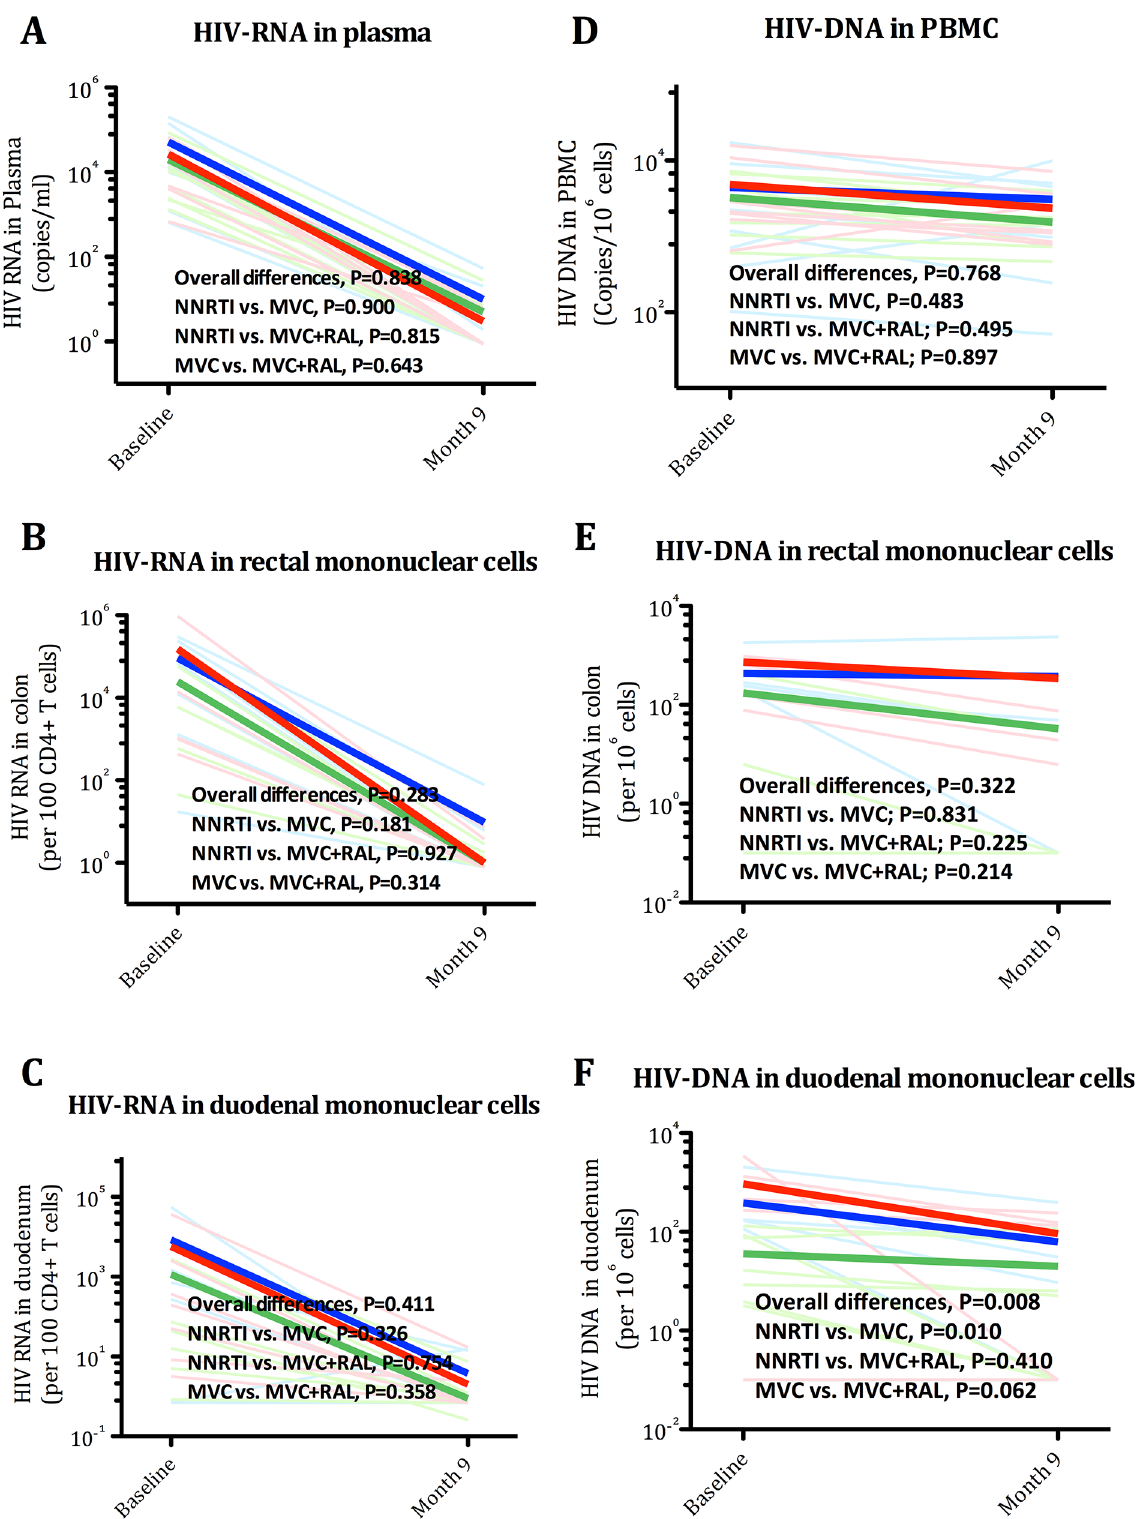
Fig 6. Effects of three ART regimens on markers of viral persistence. Panel A. HIV RNA in plasma. Panel B. Cell-associated HIV RNA in rectum. Panel C. Cell-associated HIV RNA in duodenum. Panel D. Cell-associated HIV DNA in PBMC. Panel E. Cell-associated HIV DNA in rectum. Panel F.